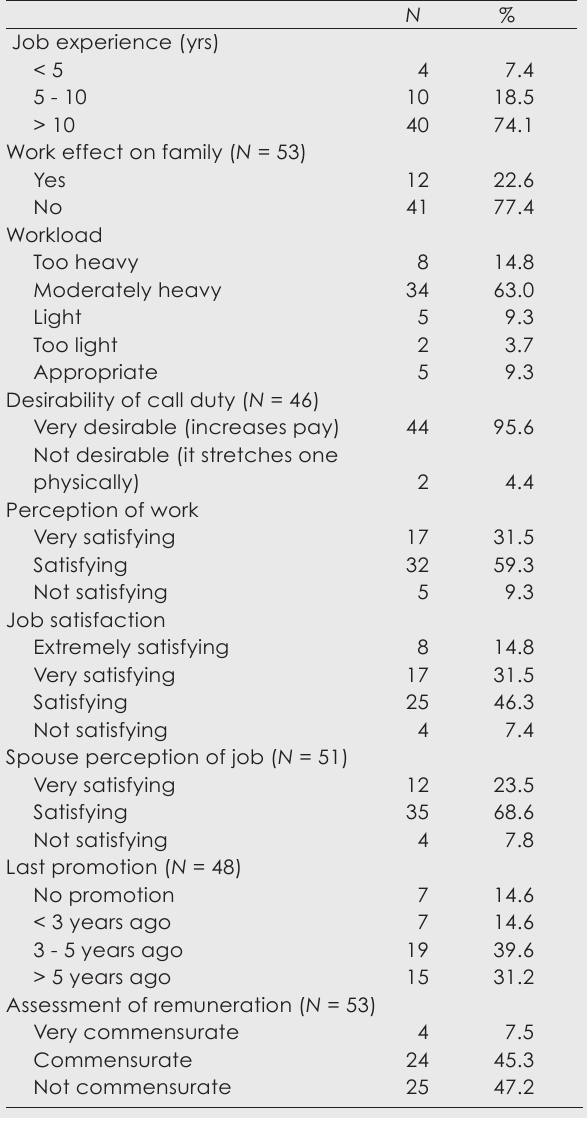
Table II. Work-related factors among UITH